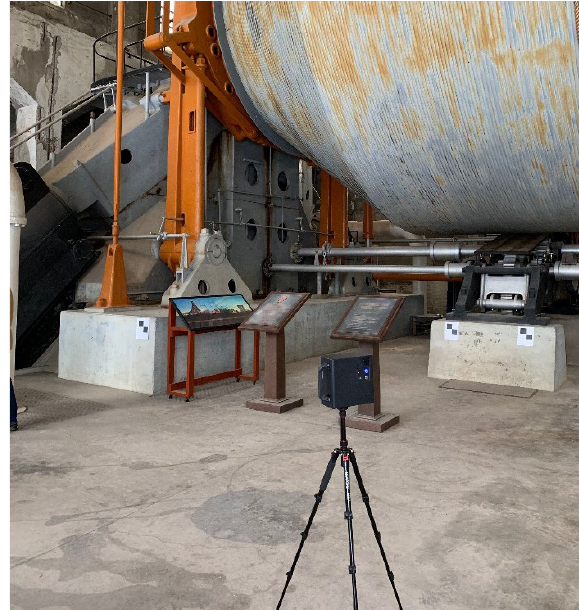
Figure 12. Data acquisition by Matterport